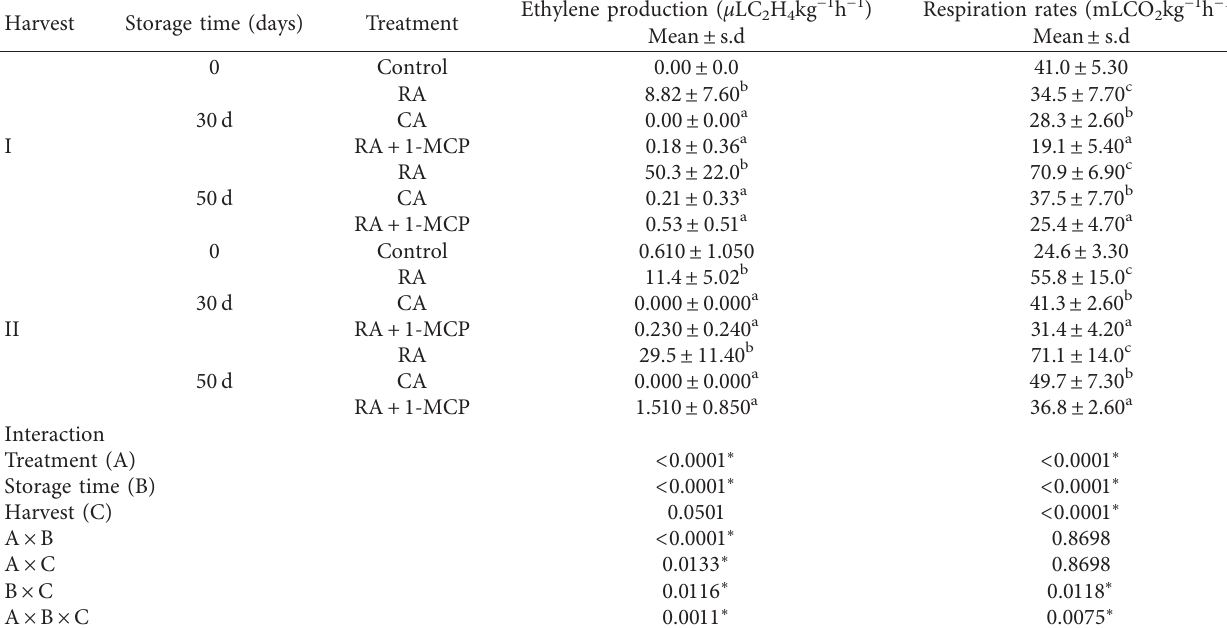
Table 3: Ethylene production and respiration rates immediately after 30 and 50 days storage at 5 ° C in “Edranol” avocado. Harvest